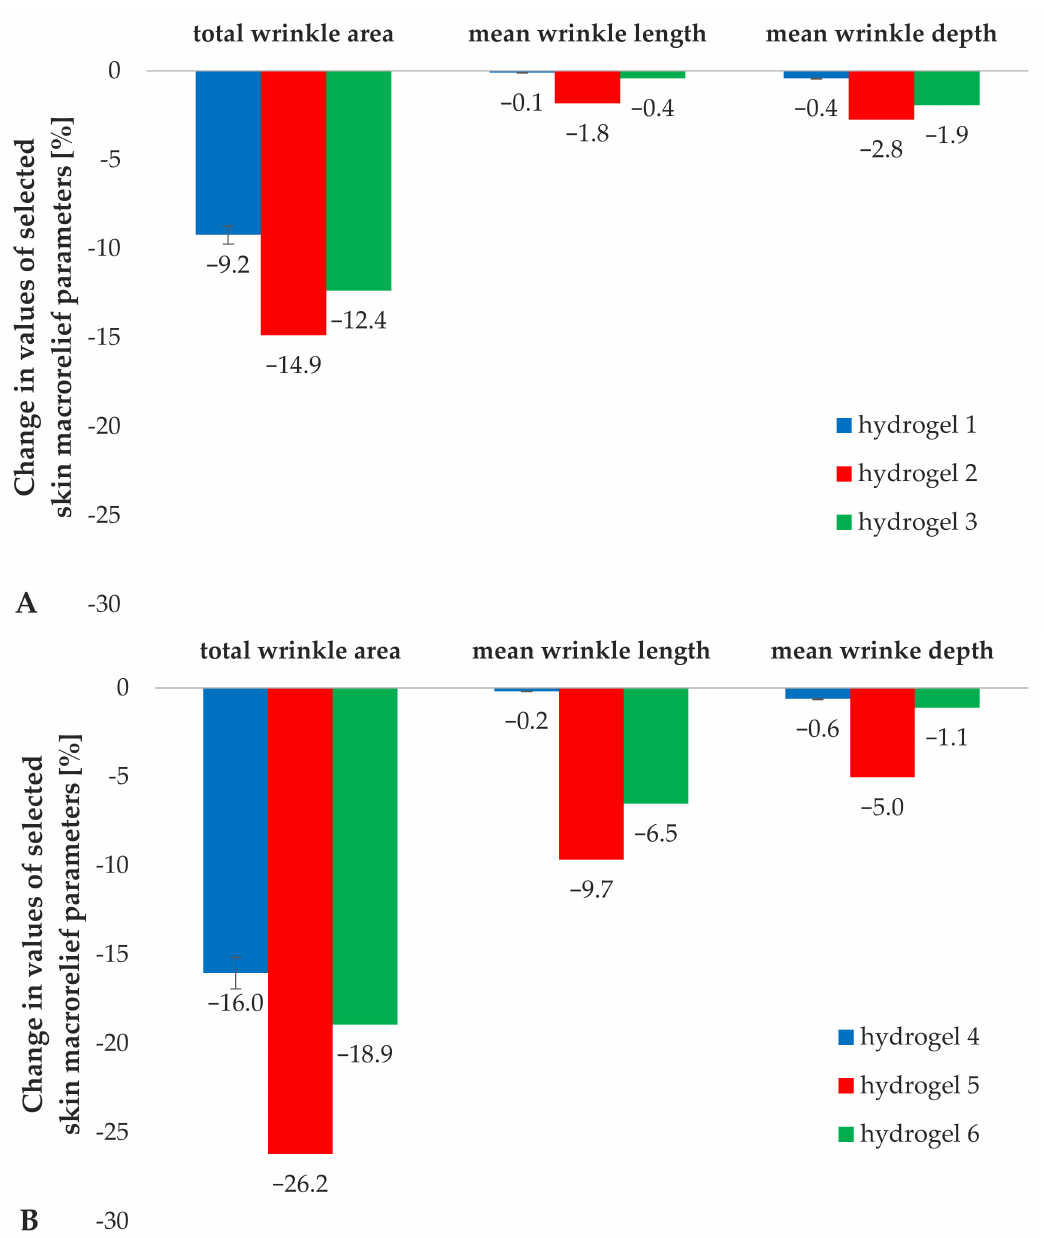
Figure 13. Changes in skin macrorelief parameters determined for hydrogel formulations 1–3 ( A ) and 4–6 ( B ) during in vivo